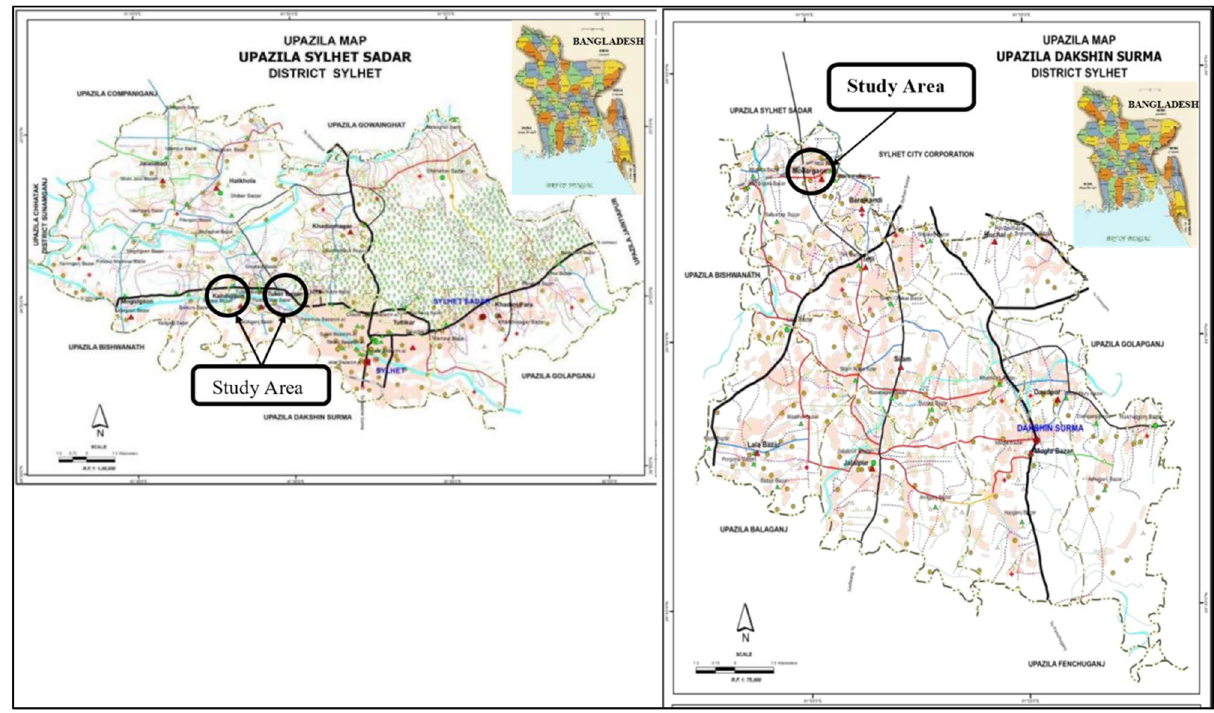
Figure 1. The study areas: Tuker Bazar and Kandergaon in Sylhet Sadar Upazila (left panel) and Mollargaon in Dakshin Surma Upazila (right panel) Source :(http://www.lged.gov.bd/ViewM